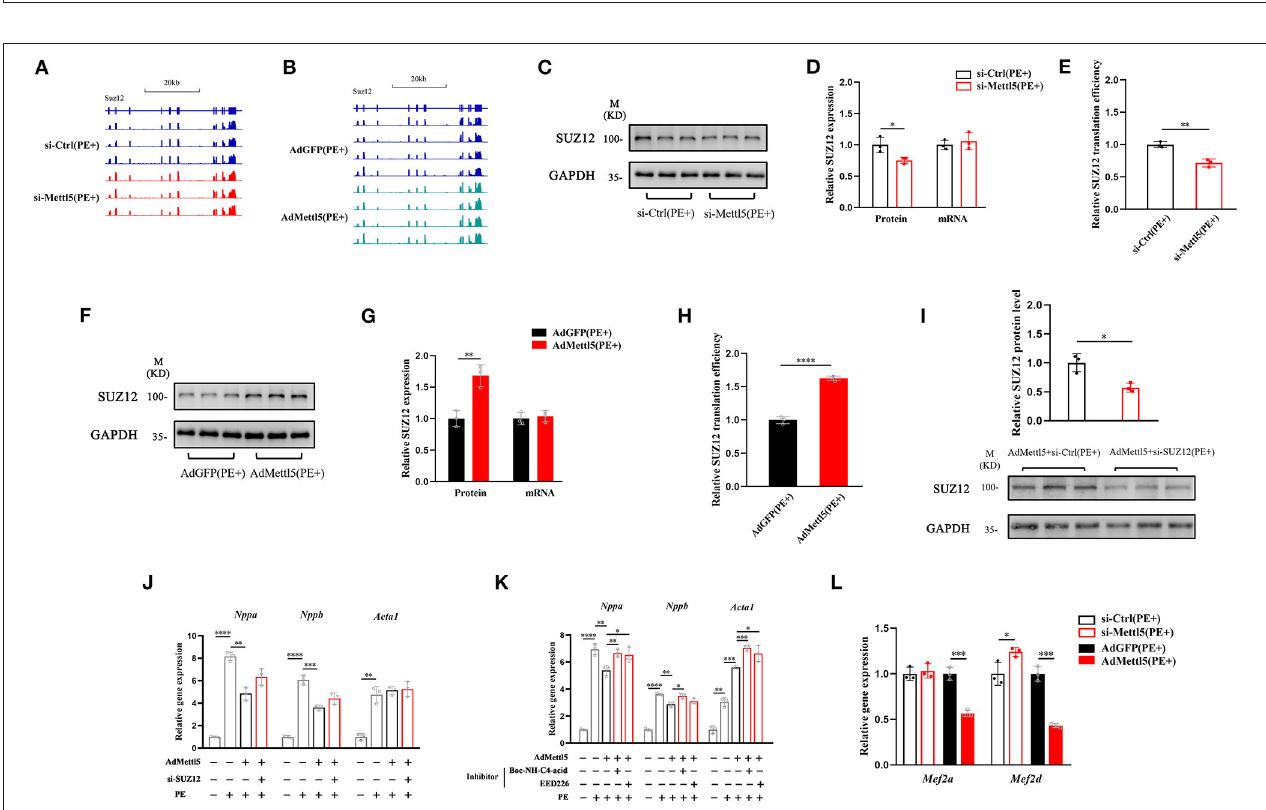
FIGURE 5 | METTL5 regulates the translation efficiency of SUZ12. (A,B) The genomic view of SUZ12 mRNA reads of RNA-seq of si-METTL5 vs. si-Ctrl and AdMETTL5 vs. AdGFP under the stimulation of PE in the IGV browser. (C) Detection of the expression of SUZ12 in si-METTL5 and si-Ctrl treated NRVCs under the stimulation of PE. GAPDH serves as control. (D) Quantification of SUZ12 protein level and qRT-PCR detection of the relative gene expression of SUZ12 in si-METTL5 and si-Ctrl treated NRVCs under the stimulation of PE. (E) The translation efficiency (TE) is presented by calculating the ratio between transcript level and protein level. n = 3 for each group. (F) Detection of the expression of SUZ12 in Ad-METTL5 and Ad-Ctrl treated NRVCs under the stimulation of PE. GAPDH serves as control. (G) Quantification of SUZ12 protein level and qRT-PCR detection of the relative gene expression of SUZ12 in Ad-METTL5 and Ad-Ctrl treated NRVCs under the stimulation of PE. (H) The translation efficiency (TE) is presented by calculating the ratio between transcript level and protein level. n = 3 for each group. (I) Detection and quantification of the knockdown of SUZ12 in Ad-METTL5 treated NRVCs under the stimulation of PE. GAPDH serves as control. n = 3 for each group. (J,K) Relative gene expression of hypertrophy markers in NRVMs treated with (H) si-SUZ12 or (I) SUZ12 inhibitors under Ad-METTL5 or Ad-GFP transfection with or without PE treatment. n = 3 in each group. (L) Relative gene expression of Mef2a and Mef2d in METTL5 knockdown and overexpression NRVCs and control cells under the stimulation of PE by RT-PCR. n = 3 in each group. The unpaired T -test was used for 2-group comparisons. * P < 0.05, ** P < 0.01, *** P < 0.001, **** P <